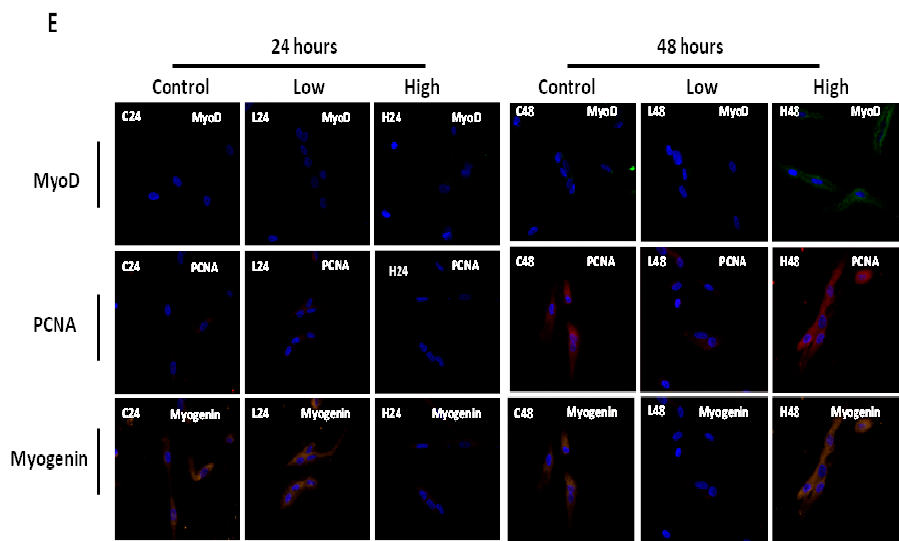
Figure 8. Concentration- and time-dependent e ff ects of low and high IL-6 concentrations on PCNA, MyoD and myogenin expression in PHMs. ( A ) Western blot determination of PCNA, MyoD and myogenin protein levels 24 h after treatment with low and high IL-6 concentrations. ( B ) Western blot determination of PCNA, MyoD and myogenin protein levels 48 h after treatment with low and high IL-6 concentrations. ( C ) Quantification of PCNA, MyoD and myogenin protein levels as shown in ( A ). ( D ) Quantification of PCNA, MyoD and myogenin protein levels as shown in ( B ). ( E ) Immunofluorescence staining for PCNA, MyoD and myogenin protein in PHMs after treatment with low and high IL-6 for 24 and 48 h. The experiment was repeated three times. Immunofluorescence images were taken at 100× magnification. Results are presented as mean ± standard error of the mean (S.E.M). Statistical analysis: ANOVA and Bonferroni post hoc test. * p < 0.05; *** p < 0.001.